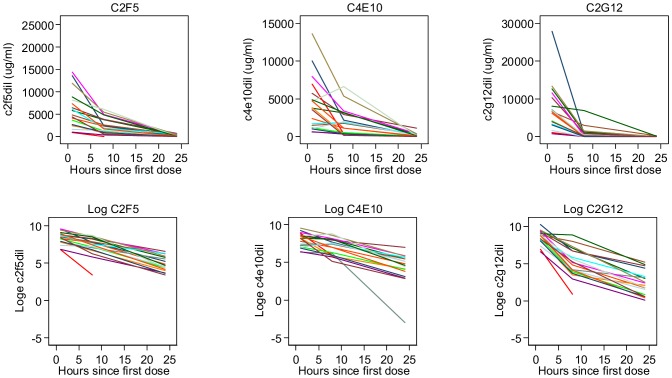
Antibody and loge antibody concentrations over three time points for individual participants given active Mabgel (high and low dose) after adjustment for dilution factors.